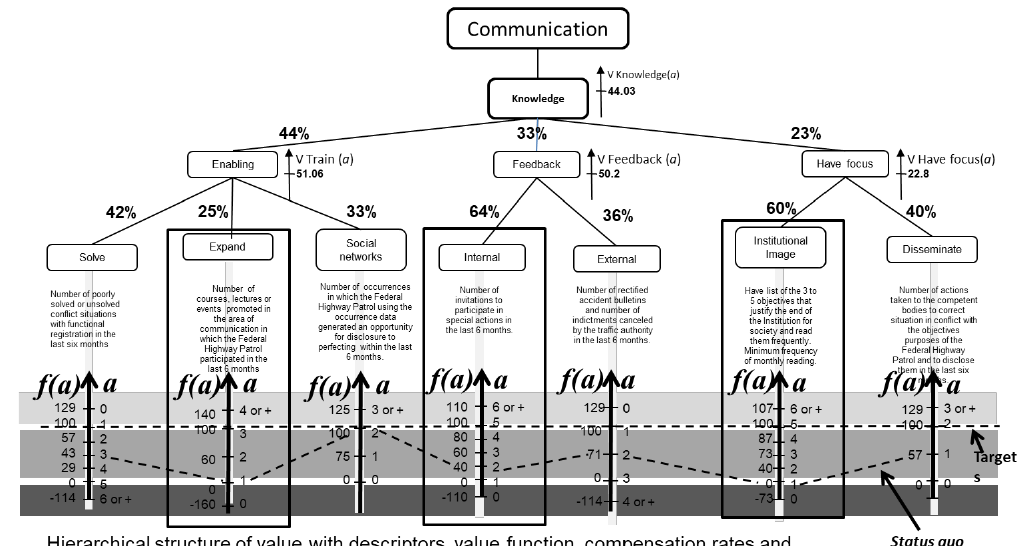
Figure 5. Compensation rates, overall value, and SQ impact on PVE-Knowledge of FPV-Com- munication.